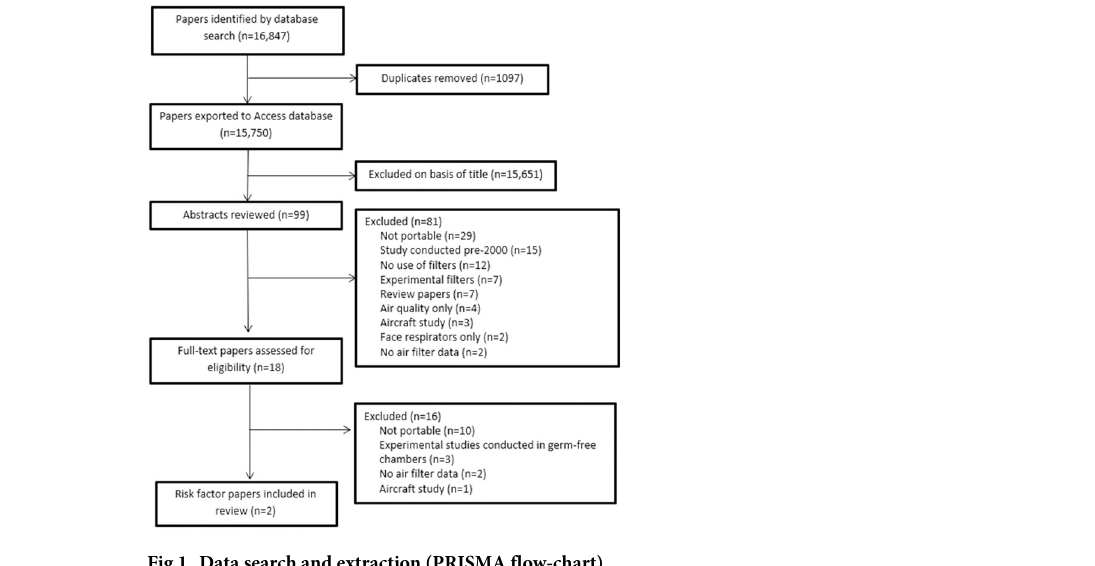
Fig 1. Data search and extraction (PRISMA